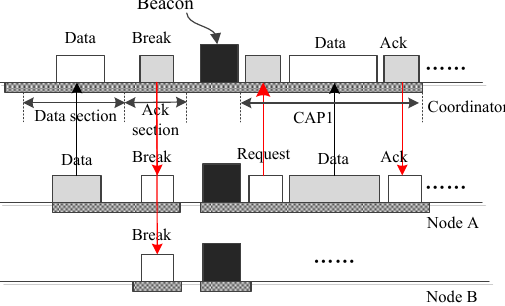
Figure 6. Only one node sends big emergency data to the